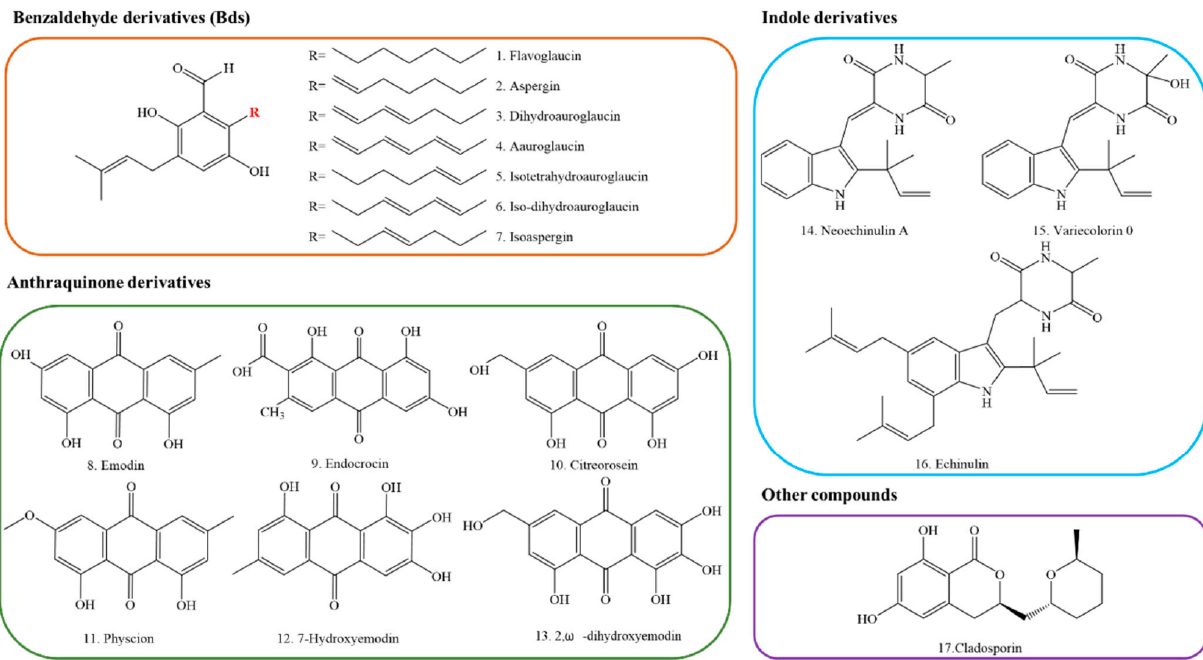
Figure 1. Chemical formulations of some common secondary metabolites in Eurotium cristatum